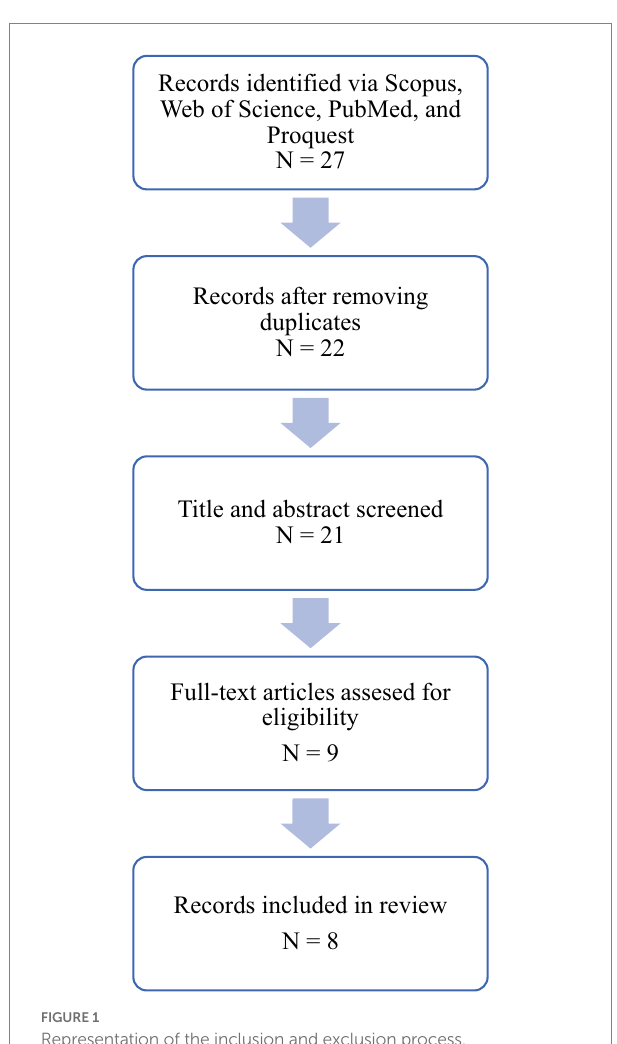
FIGURE 1 Representation of the inclusion and exclusion